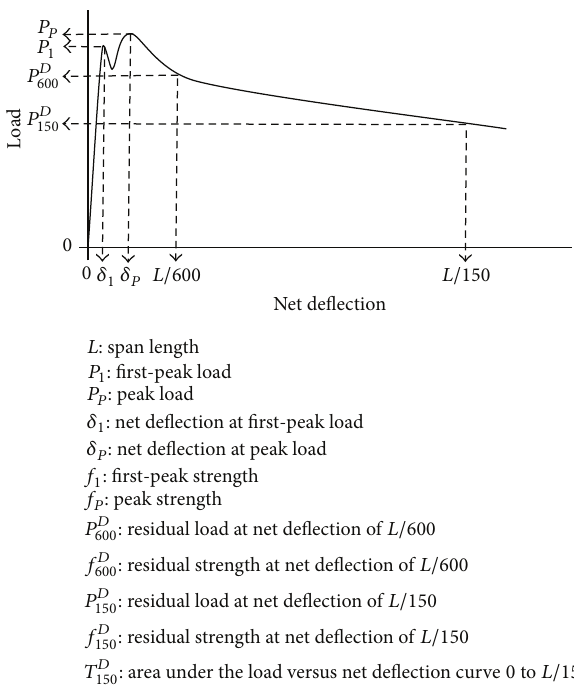
Figure 2: Flexural toughness defined by ASTM C1609. 𝑅 𝐷 𝑇,150 = /𝑓 𝑏𝑑 2 × 100 %, where 𝑏 is the width (mm) of the specimen 150𝑇 𝐷 1 150 and 𝑑 is the height (mm) of the